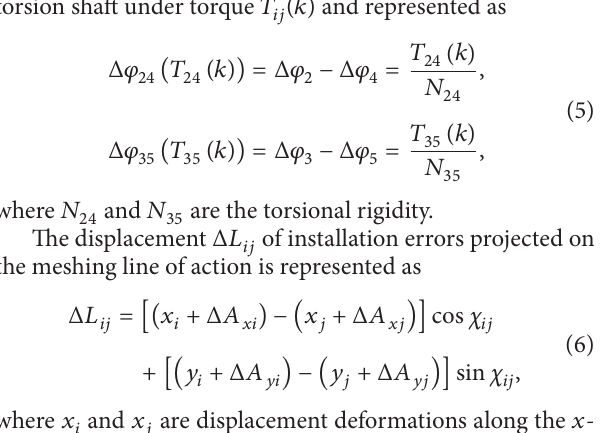
𝐼 = 𝑟 /𝑟 = 𝑍 /𝑍 𝑖𝑗 𝑏𝑗 𝑏𝑖 𝑗 𝑖 ). 𝑍 𝑍 𝑖 and 𝑗 represent